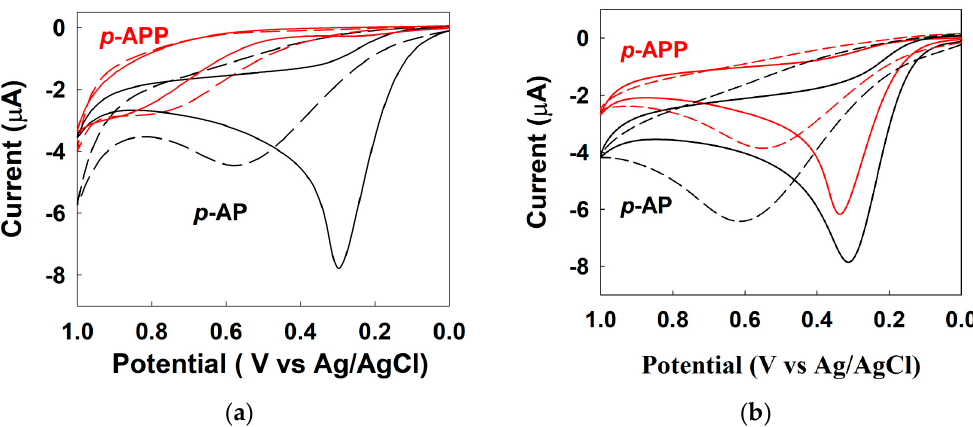
Figure 2. ( a ) Cyclic voltammograms of the SAM-modified ITO electrode with / without (solid / dashed line) the Fc moiety in an electrolyte solution containing 1 mM p -AP (Black) or 1 mM p -APP (red). Scan rates were 10 mV / s. ( b ) Cyclic voltammograms of the SAM-modified ITO electrode with / without (solid / dashed line) the Fc moiety after incubating with ALP-conjugated streptavidin in an electrolyte solution containing 1 mM p -AP ( Black ) or 1 mM p -APP ( Red ). Scan rates were 50 mV / s.